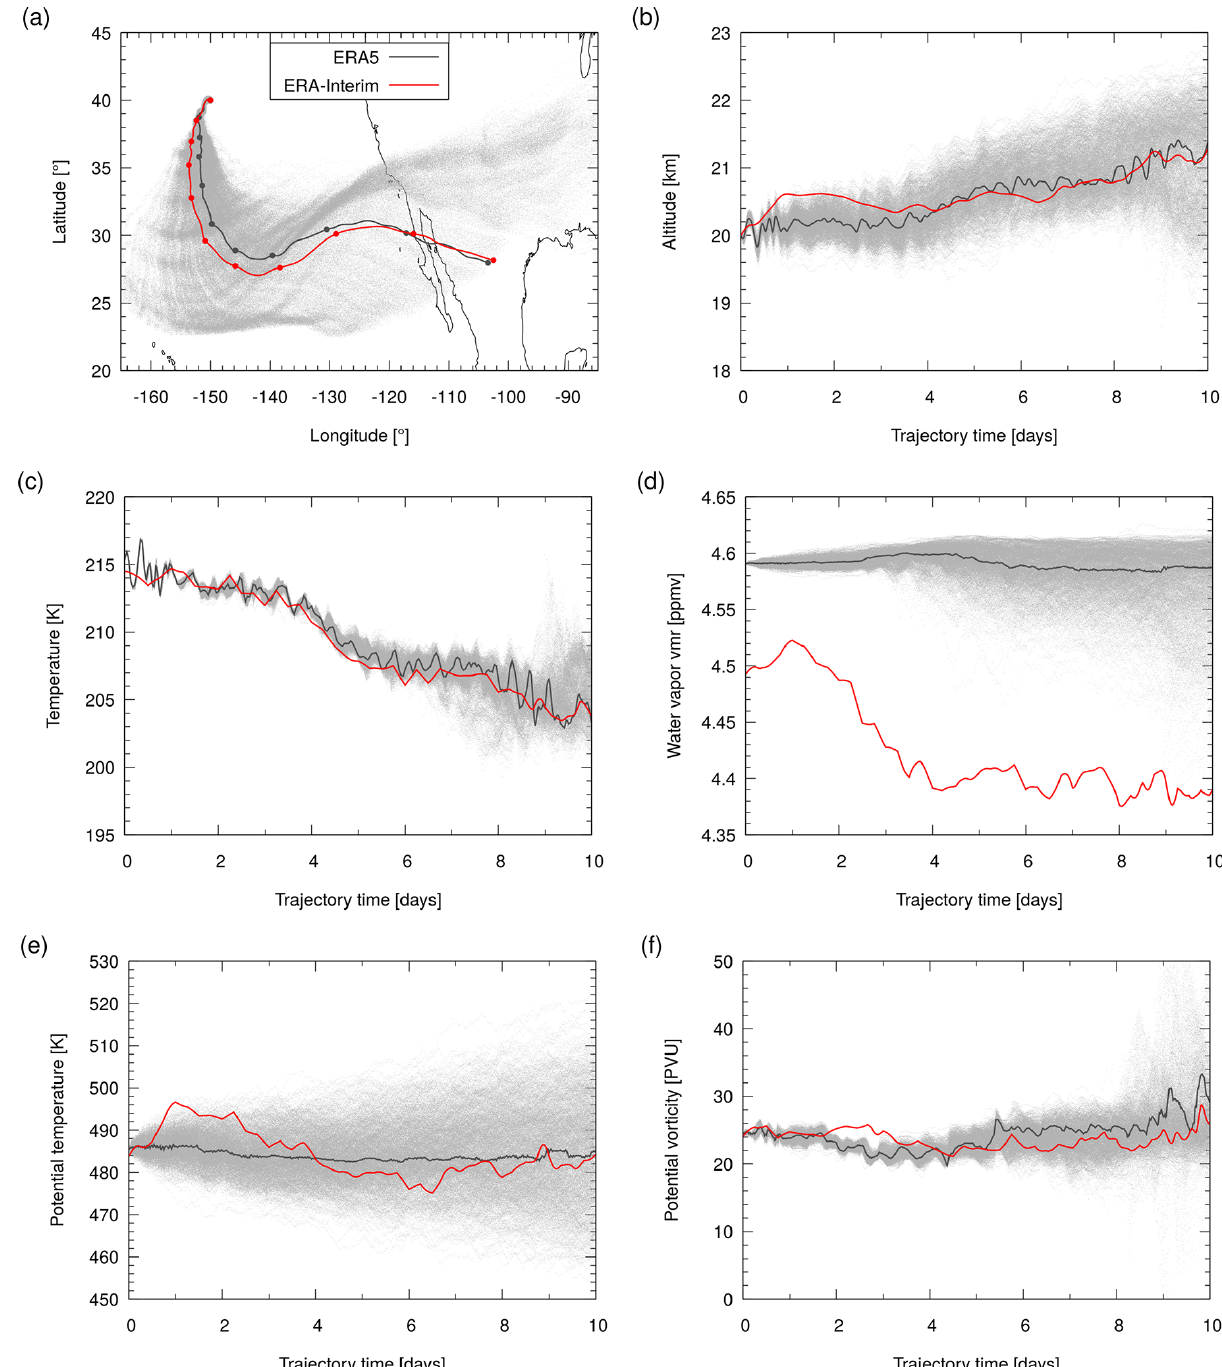
Figure 5. Particle positions (a, b) , meteorological variables (c, d) , and dynamical tracers (e, f) sampled along a 10-day forward trajectory calculated with either ERA-Interim (red) or ERA5 (dark gray). Also shown is a 1000-member set of ERA5 trajectories with additional modeling of diffusion and subgrid-scale wind fluctuations (light gray). All trajectories were launched on 1 January 2017, 00:00UTC at (40 ◦ N, 150 ◦ W) and 58.2hPa (an altitude of about 20km). The model output was saved every 20min. Bullet points in (a) indicate 24h